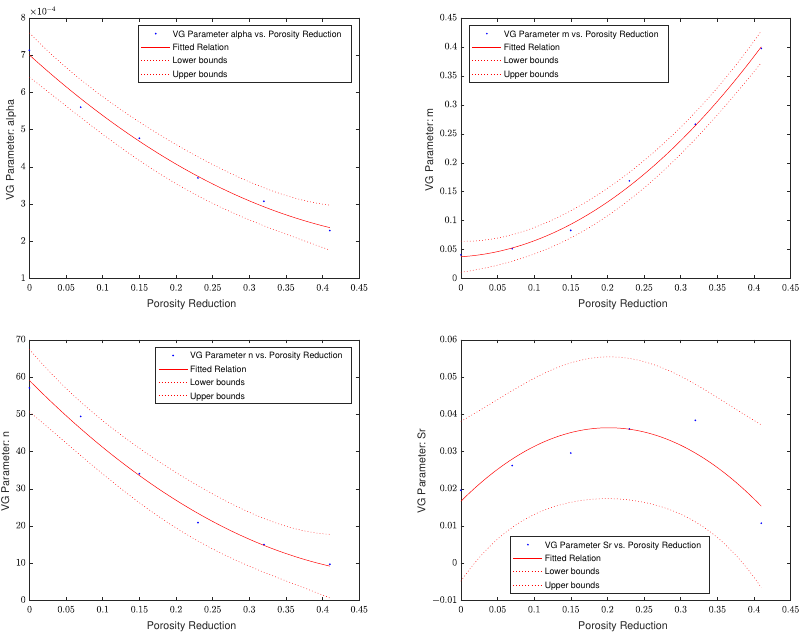
Figure 11. Observed dependency of the Van Genuchten parameters on the porosity reduction: from top left to bottom right, α , m , n , and residual saturation S r for experiment 2D2.